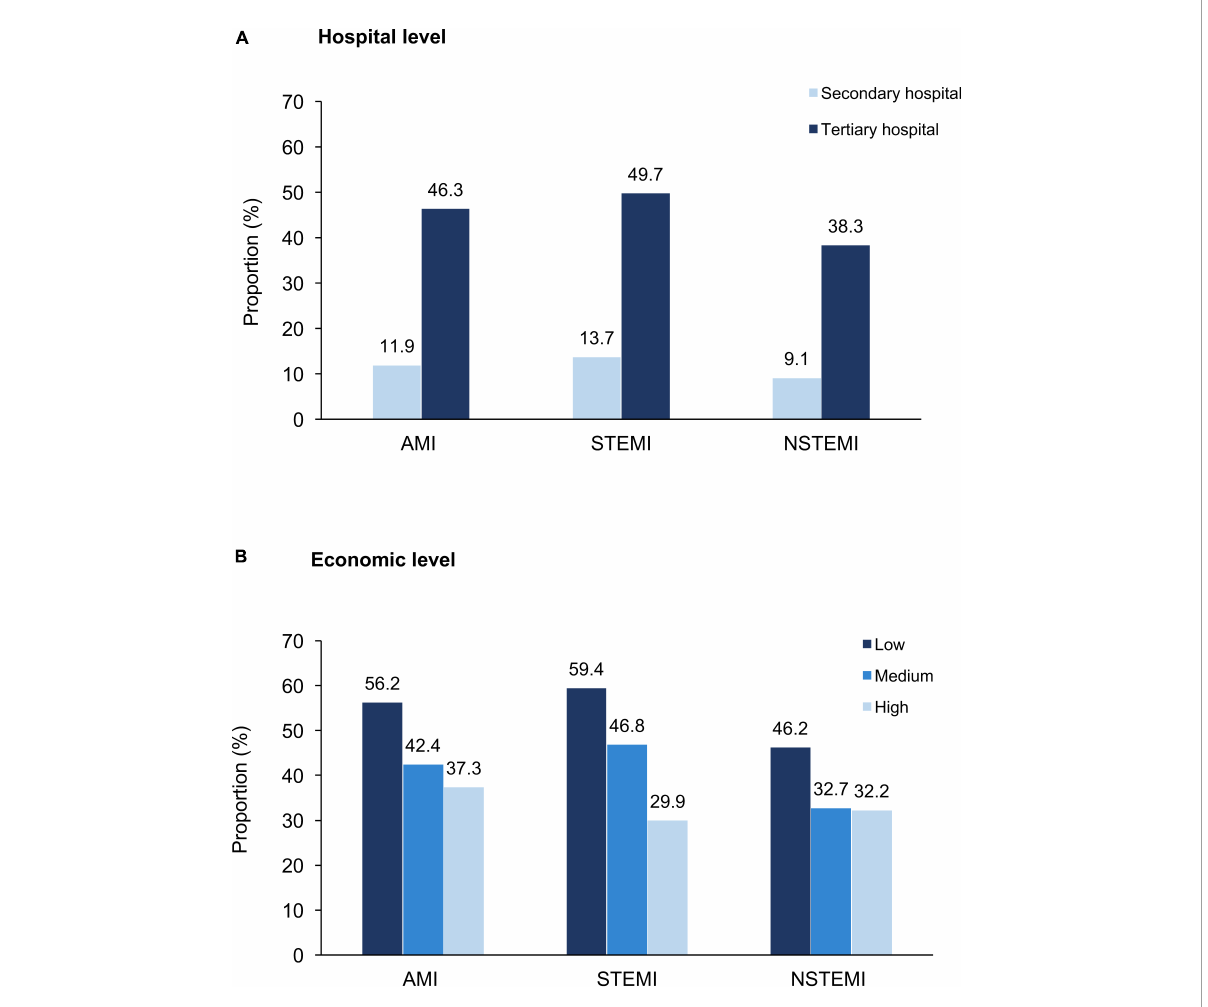
FIGURE3 Proportion of inter-hospital transfer in patients with AMI, by hospital characteristics. (A) Hospital level and (B) Economic level. AMI, acute myocardial infarction; NSTEMI, non-ST-segment elevation myocardial infarction; and STEMI, ST-segment elevation myocardial